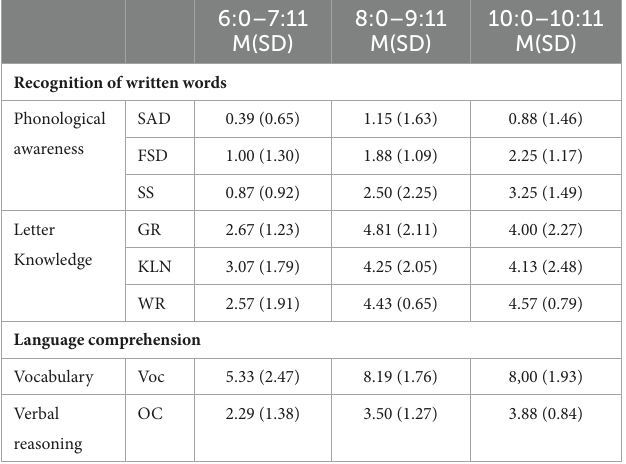
TABLE 2 Descriptive statistics for reading precursors by age